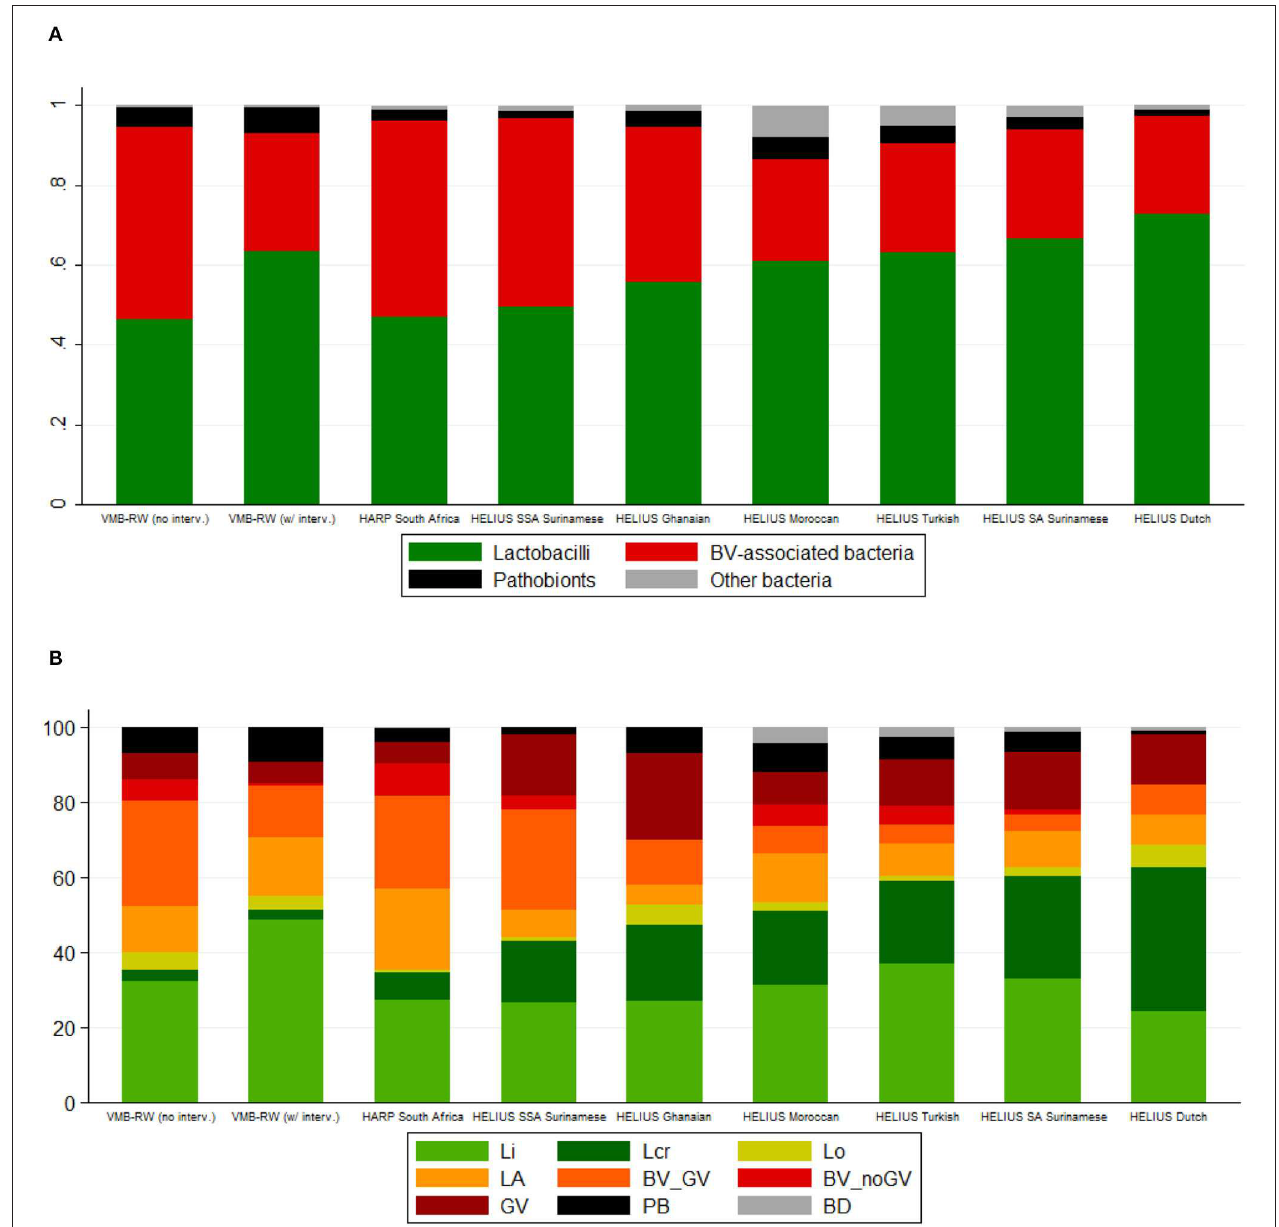
FIGURE 1 | Bar charts by study, intervention exposure (VMB Rwanda) and ethnic group (HELIUS). (A) Mean relative abundance of bacterial groups. (B) Cumulative percentage of women with a specific VMB type. BV, bacterial vaginosis; BD, Bifidobacterium -dominated; BV_GV, polybacterial Gardnerella vaginalis -containing; BV_noGV, polybacterial but low G. vaginalis ; CI, confidence interval; GV, G. vaginalis -dominated; interv , (study product) interventions; LA, lactobacilli and anaerobes; Lcr, L. crispatus -dominated; Li, L. iners -dominated; Lo, other lactobacilli-dominated; NA, not applicable; PB, pathobionts-containing; SA, South-Asian; SSA, sub-Saharan African; VMB, vaginal microbiota; VMB-RW , Rwanda VMB study. Rwanda VMB study samples collected at the screening and Month 6 visits in all randomization groups, and at the Month 1 and Month 2 visits in the no-intervention group, were considered not influenced by the interventions.